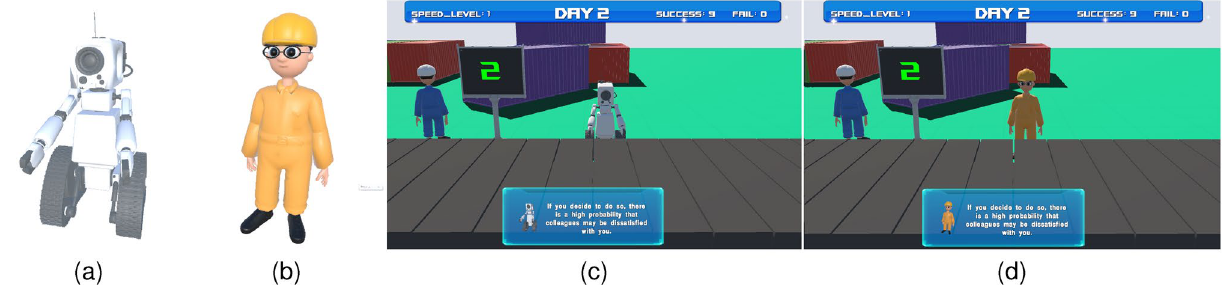
Figure 5. Design of human-likeness and responsiveness of agent in Experiment 1. ( a ) The robot-like virtual agent. ( b ) The human-like virtual agent. ( c ) A snapshot of text suggestions given by a robot-like agent. ( d ) A snapshot of text suggestions given by a human-like agent. See accompanying demo Video for animation